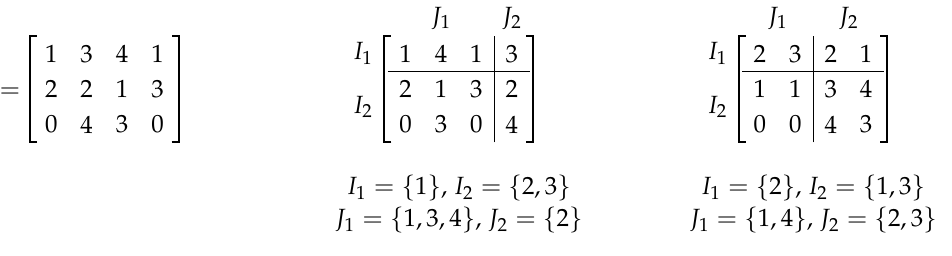
Figure 1. The example shows two ( 2,2 ) -co-clusterings (middle and right) of the same matrix A (left-hand side). It demonstrates that by sorting rows and columns according to the co-clustering, the clusters can be illustrated as submatrices of this (permuted) input matrix. The cost of the (2,2)-co-clustering in the middle is three (because of the two left clusters), and that of the (2,2)-co-clustering on the right-hand side is